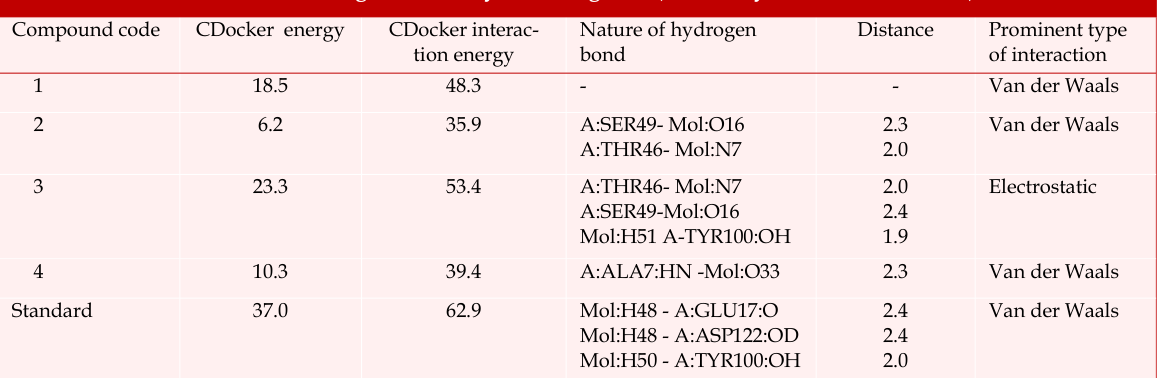
Statistical docking results of synthetic ligands (Discovery Studio 3.5 software)